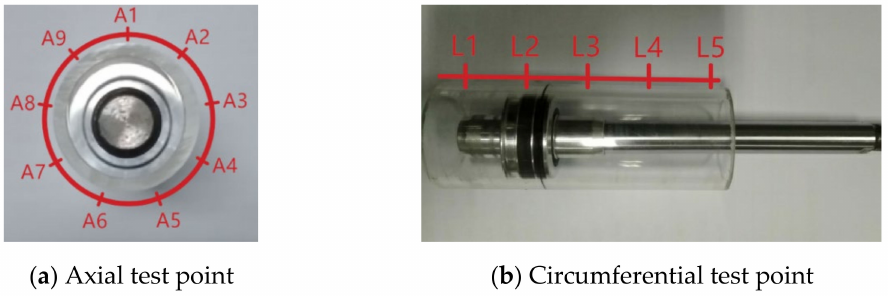
Figure 3. Distribution of test points for the cylinder contact width.